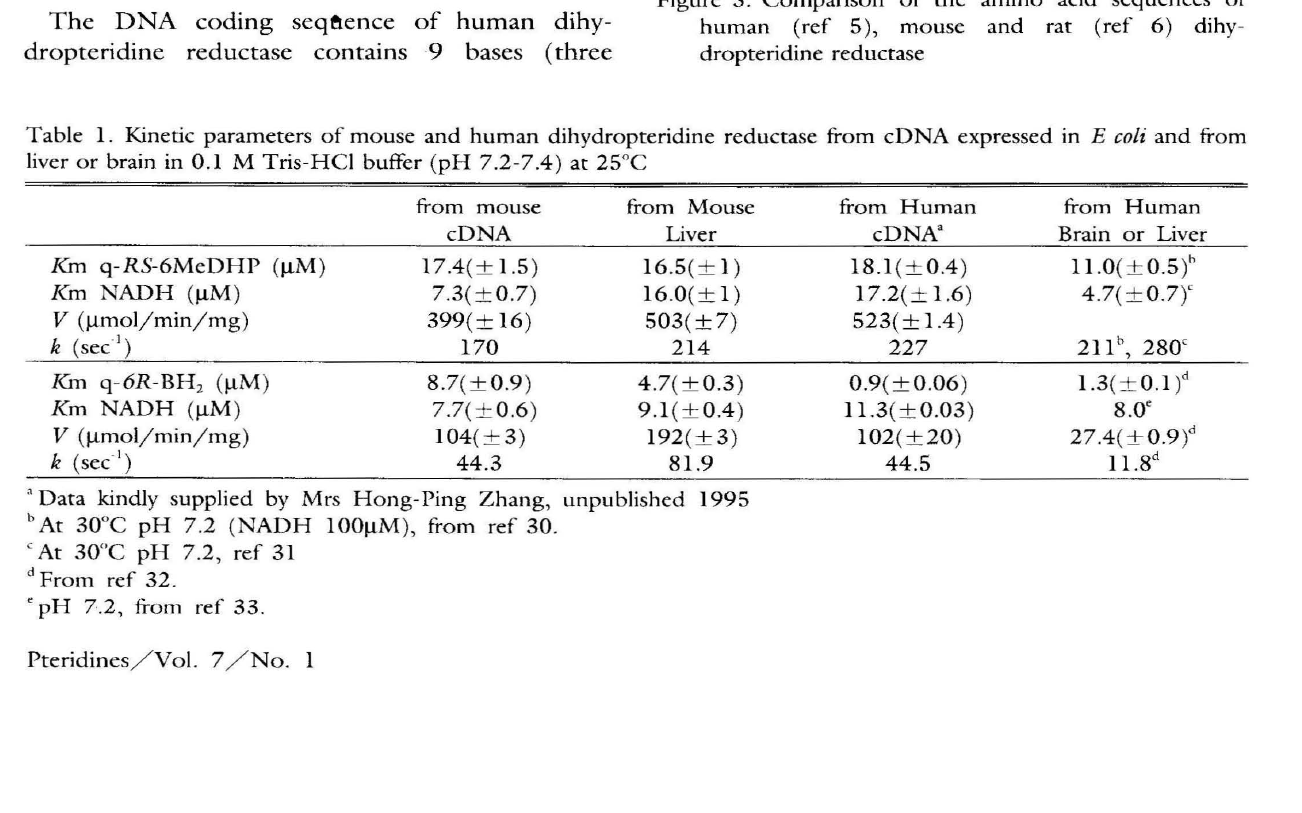
Figure 3. Comparison of the amino acid sequences of human (ref 5), mouse and rat (ref 6) dihy dropteridine reductase